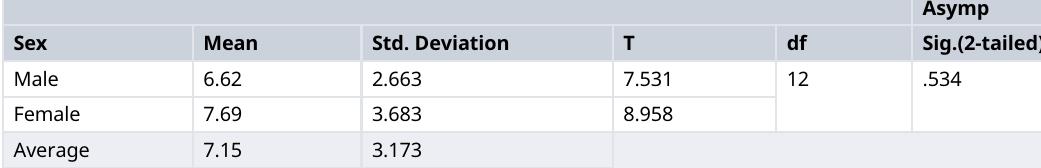
Table 3. Mann-Whitney U-test of male and female students' results in the reading